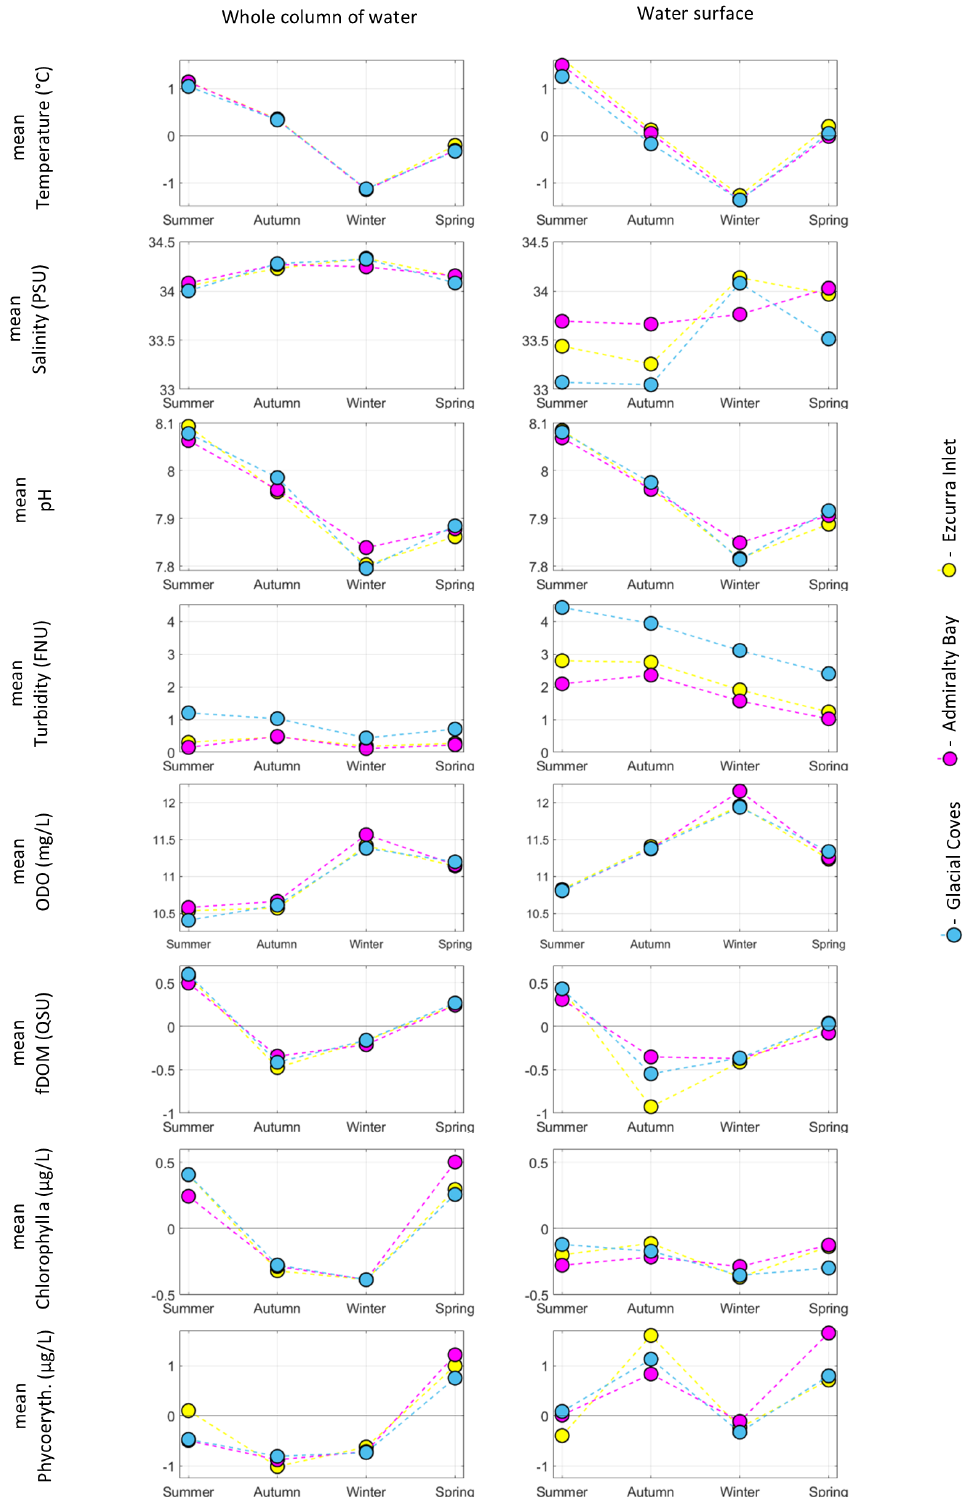
Figure 6. Mean values of measured properties dependent on season for the whole water column and the top 5m of surface water.